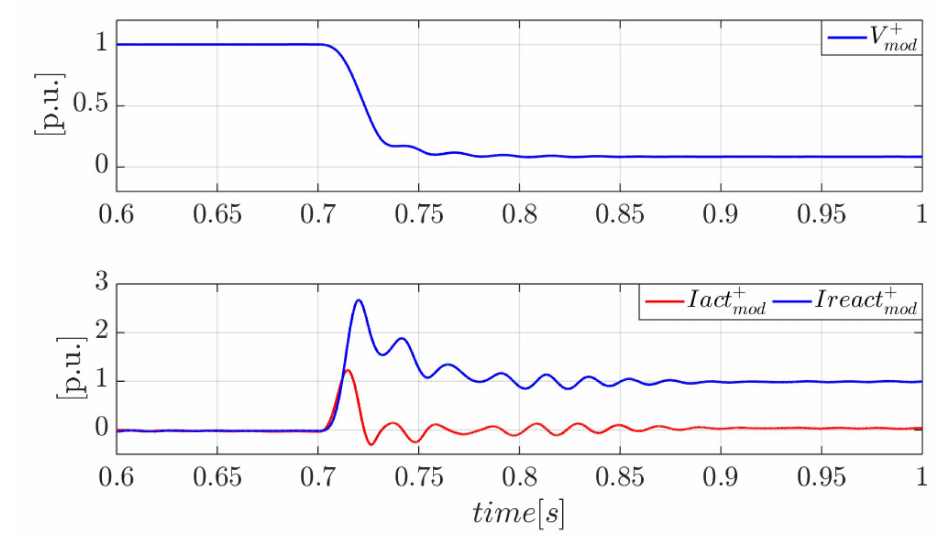
Figure 18. GFM converter positive sequence voltage and currents during a balanced fault with 0.95 p.u. depth.